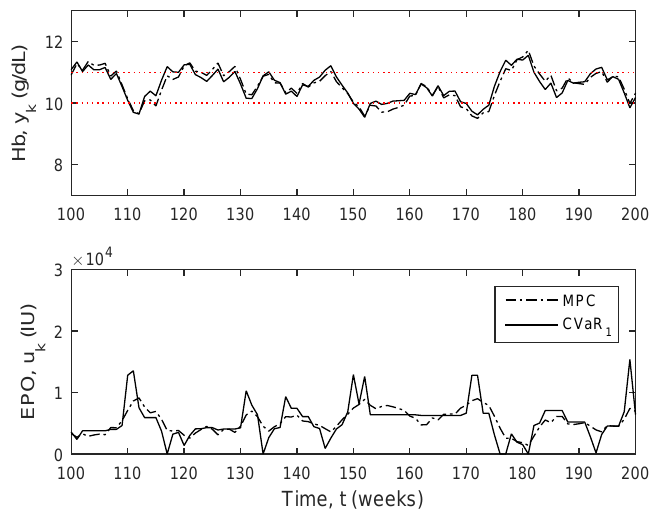
Figure 6. Comparisons to CVaR 1 for the uniform distribution.